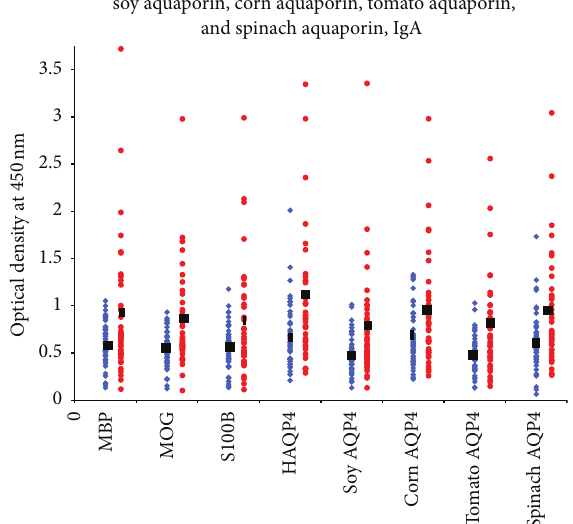
Figure 2: IgA antibody values of RRMS patients (blue diamond) versus controls (red circle): MBP, MOG, S100B, human AQP4, soy aquaporin, corn aquaporin, tomato aquaporin, and spinach aqua- porin. The levels of serum IgA antibodies against all tested antigens were significantly higher in patients than in controls.